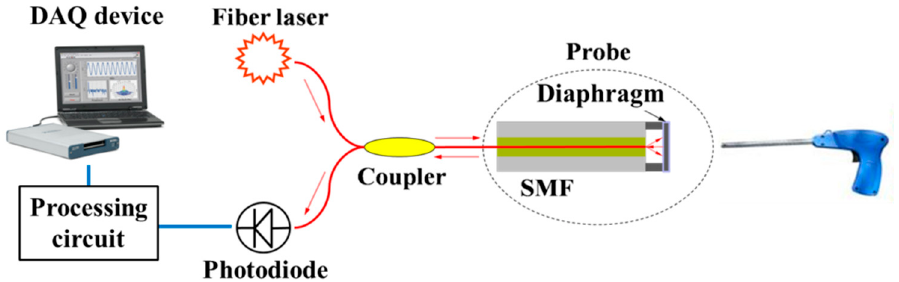
Figure 1. Schematic of the proposed ultrasonic sensing system. DAQ, data acquisition; SMF, single mode fiber.